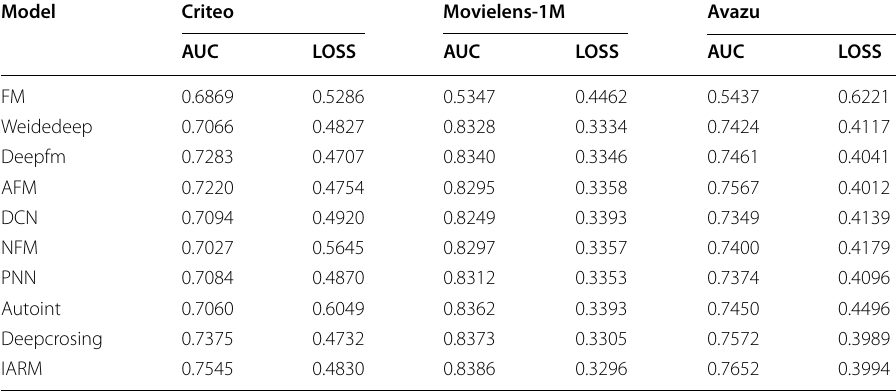
Table 3 IARM’s performance was studied using ablation tests Data